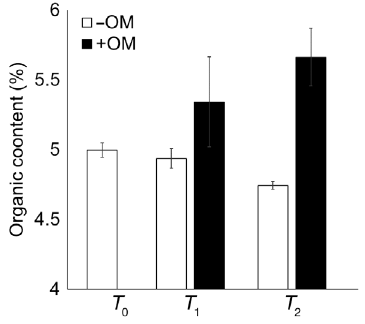
Fig. 4. Effect of addition of organic matter (−OM/+OM), in the form of biodeposits from mussels, on the organic content in the sediment during the experiment. T 0 : samples at start of experiment; T 1 : samples after 1 wk; T 2 : samples after 3 Table 4. ANOVA of sediment oxygen uptake (SOU), sediment− water phosphate fluxes and sediment organic matter (OM) content in sediments affected by the experimental treatments. Significant (p < 0.05) effects in bold